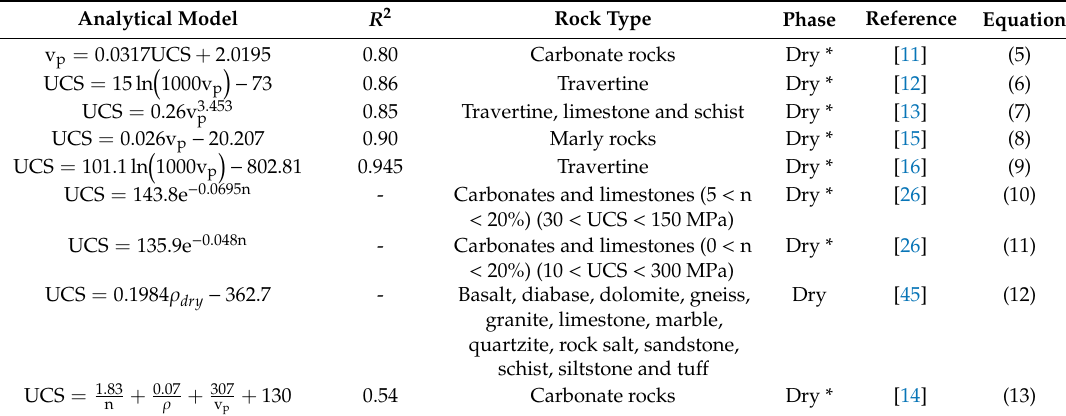
Table 2. Existing simple and multiple analytical models between UCS (MPa) and index properties